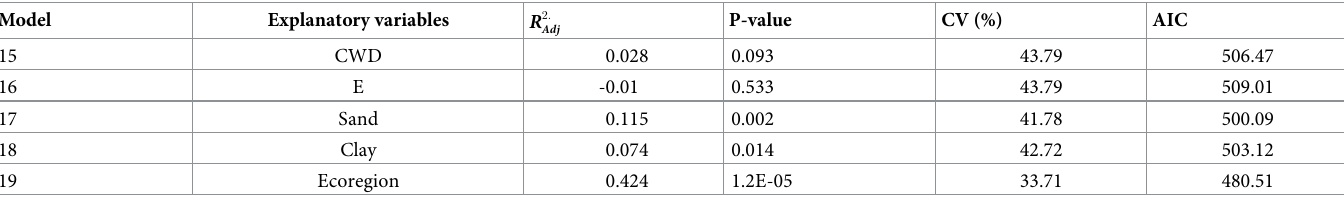
Table 6. Effect of environmental factors on tree aboveground biomass density of 68 cerrado sensustricto sites in Brazil, using LR models.